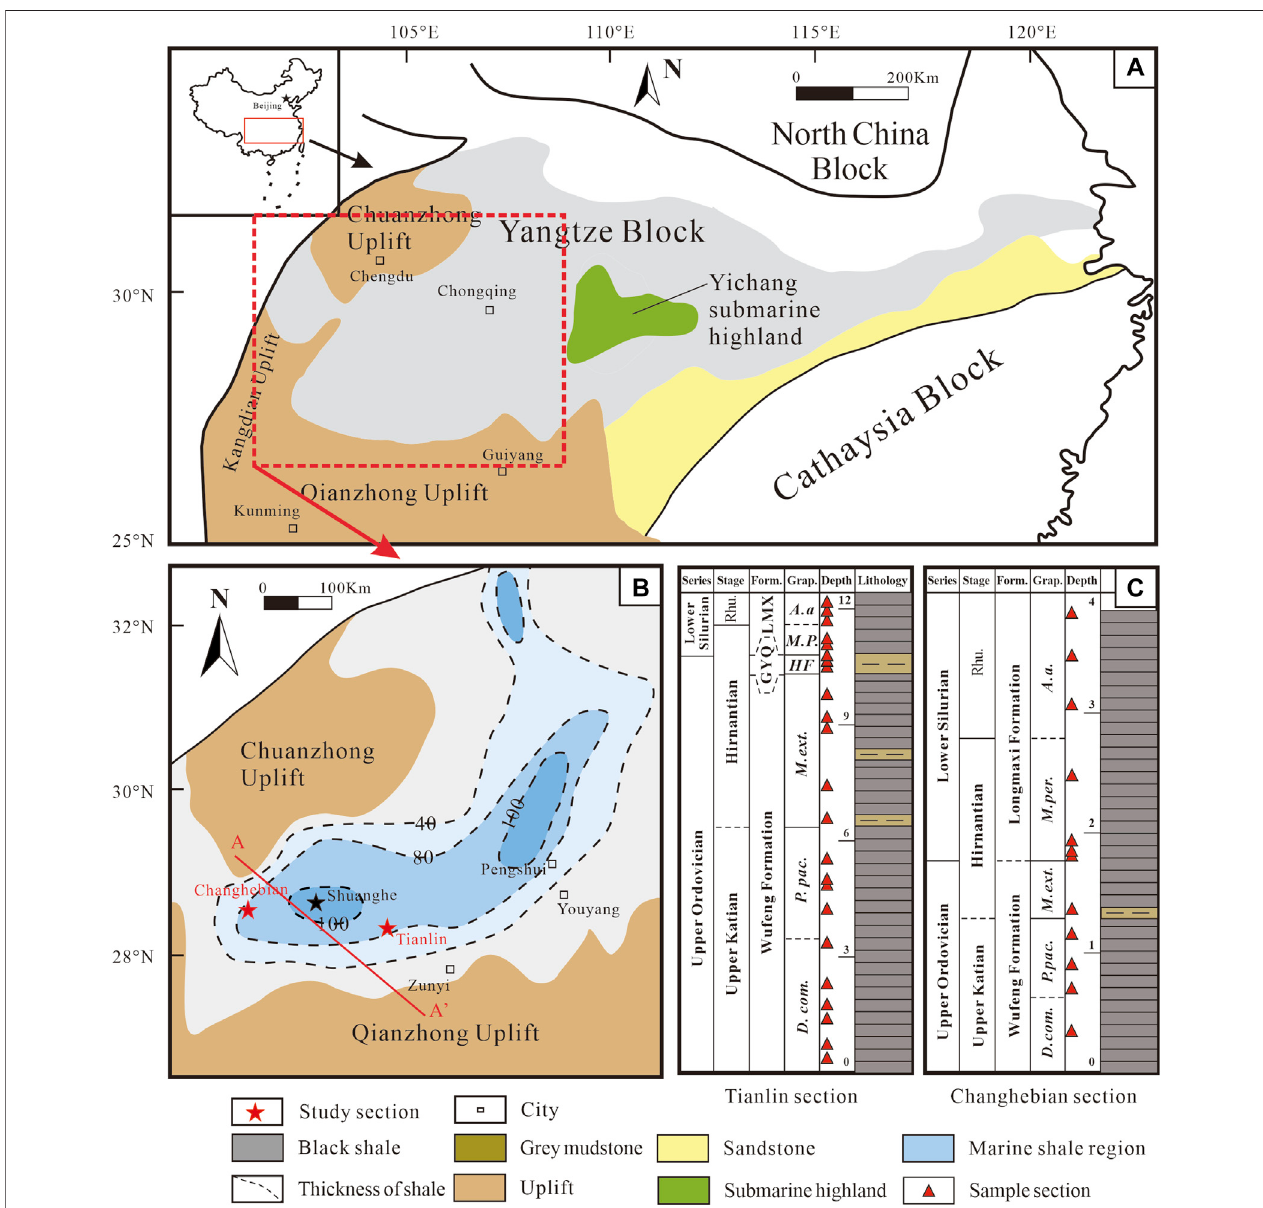
FIGURE1|(A) PaleogeographicmapoftheUpperYangtzeBasin(Chenetal.,2004). (B) LocationsoftheTianlin,Changhebian, andShuanghesections(Liuetal., 2016).The dotted lineinthe fi gure showsthe locationofthe easternand southern depocenters withintheUpper Yangtze Basin(Liang etal., 2009).LineA-A ’ represents the cross-section in Figure 11 . (C) Comparison diagram of biostratigraphy in the study sections (graptolite biozones based on Chen et al. (2004)). GYQ, Guanyinqiao Formation; HF, Hirnantia Fauna; D. com, Dicellograptus complexus; P. pac, Paraorthograptus paci fi cus; M. ext., Metabolograptus extraordinarius; M.P., Metabolograptus persulptus; A. a., Akidograptus ascensus.